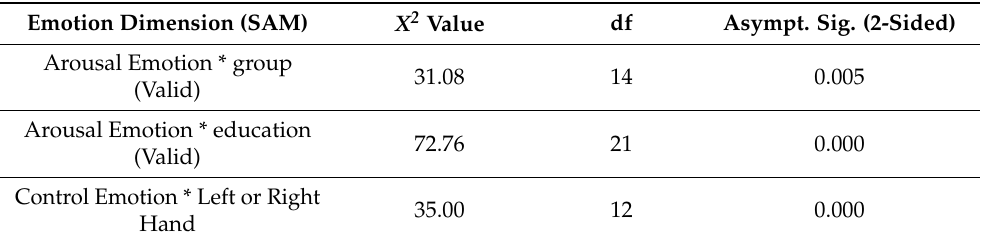
Table 7. X 2 multidimensional test on behavioral